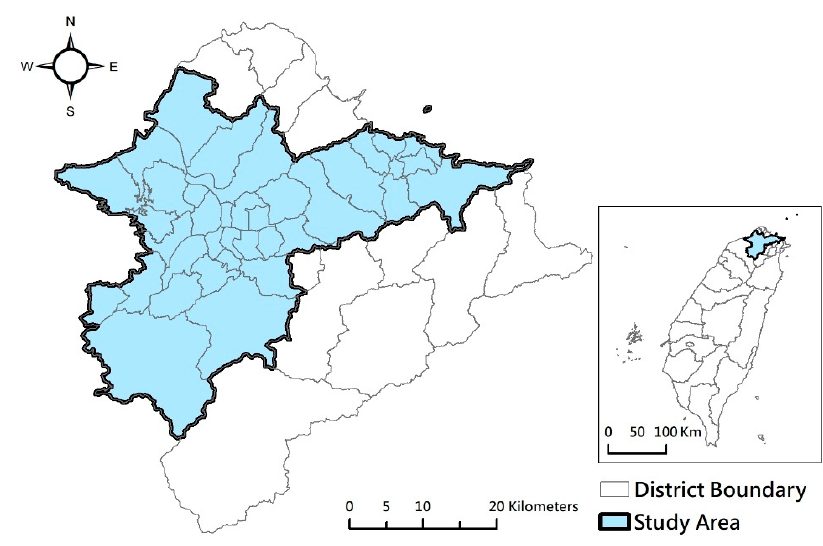
Figure 1. Study Figure 1. Study area.